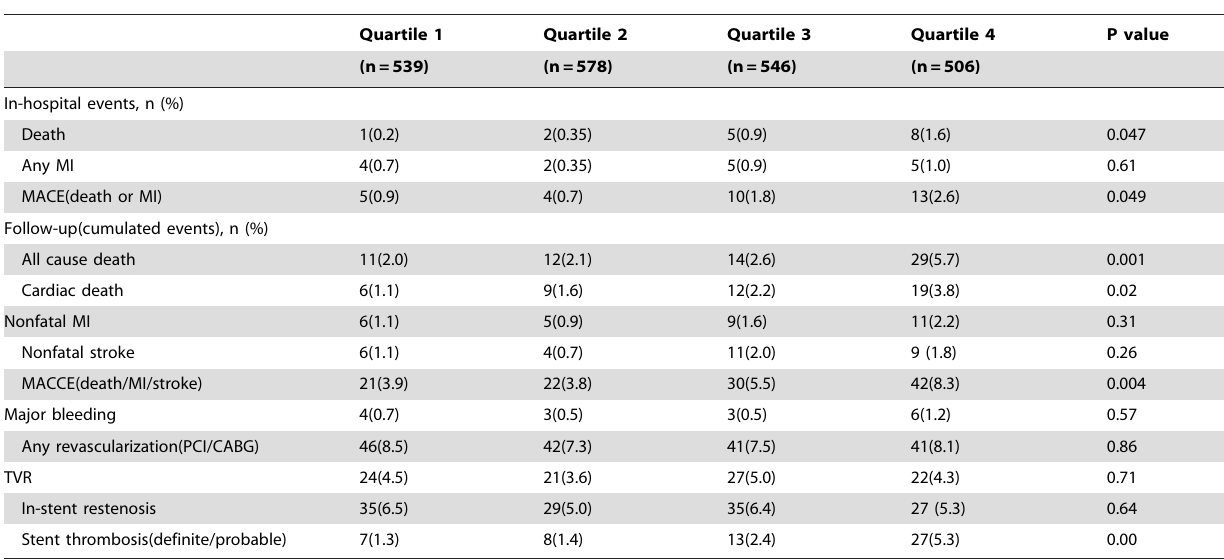
Table 3. Clinical events from PCI until discharge and end of follow up by Quartile of